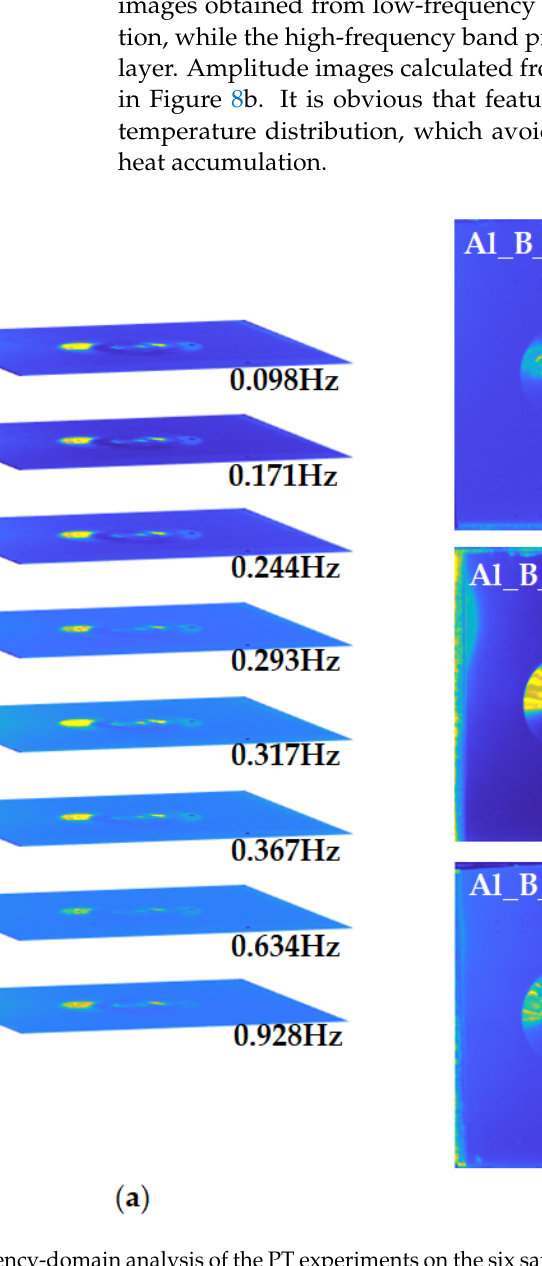
Figure 8. Frequency-domain analysis of the PT experiments on the six samples: ( a ) amplitude imaging on different frequency Figure 8. Frequency ‐ domain analysis of the PT experiments on the six samples: ( a ) a mplitude imaging on different fre ‐ points of Al_G_60J sample; ( b ) typical amplitude imaging results on six quency points of Al_G_60J sample; ( b ) typical amplitude imaging results on six samples.